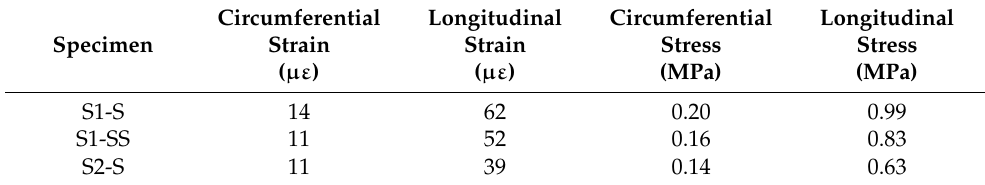
Figure 9. Failure diagram of self-stressed strengthened specimens. ( a ) Cracks on LCSS of specimen S1-S; ( b ) Fractures on LCSS of specimen S1-S; ( c ) Fractures on LCSS of specimen S1-SS; ( d ) Fractures on LCSS of specimen S2-S. Table 6. Results of